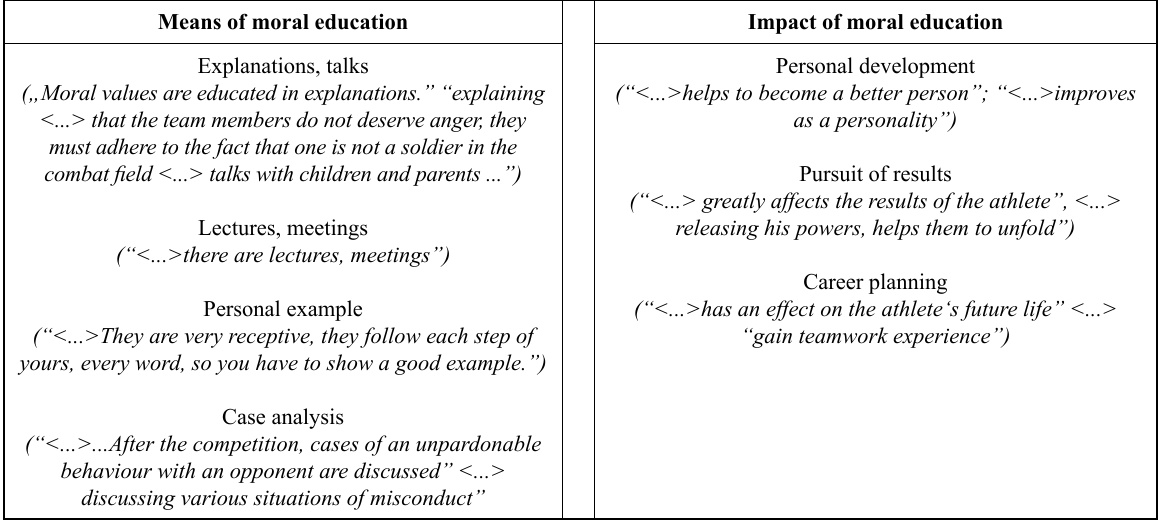
Table 4. Coach’s opinions on the means of moral education and their